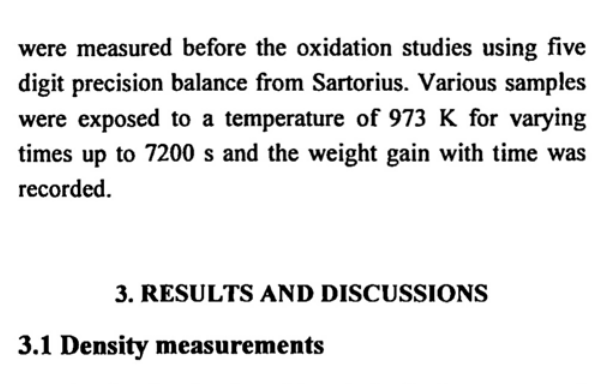
Density achieved for ternary and quaternary samples at RS pressure of 111